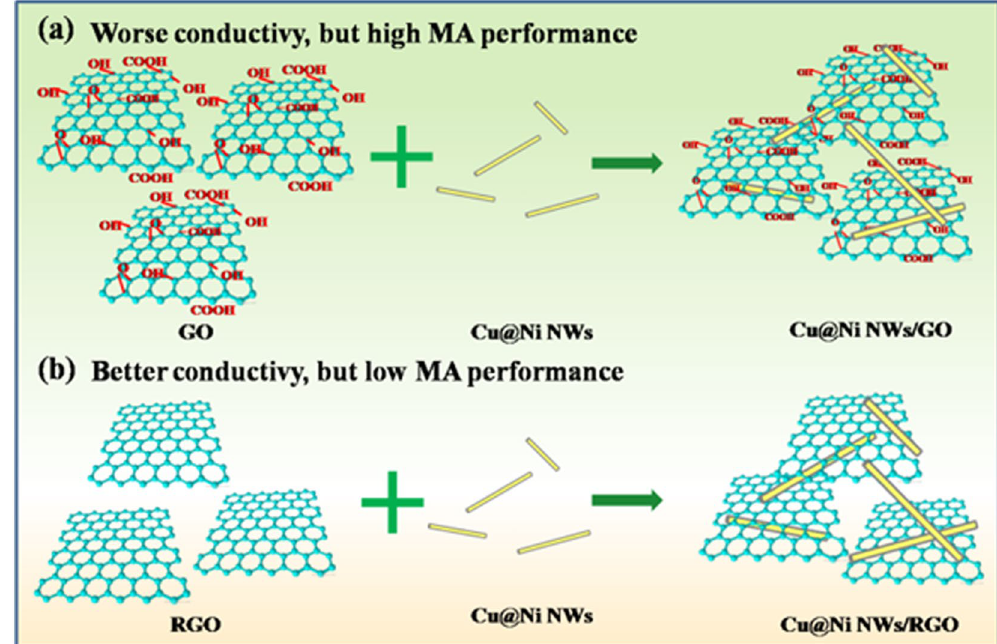
Figure 11. Schematic illustrations of the preparation process of Cu@Ni NWs/GO ( a ) and Cu@Ni NWs/RGO ( b )